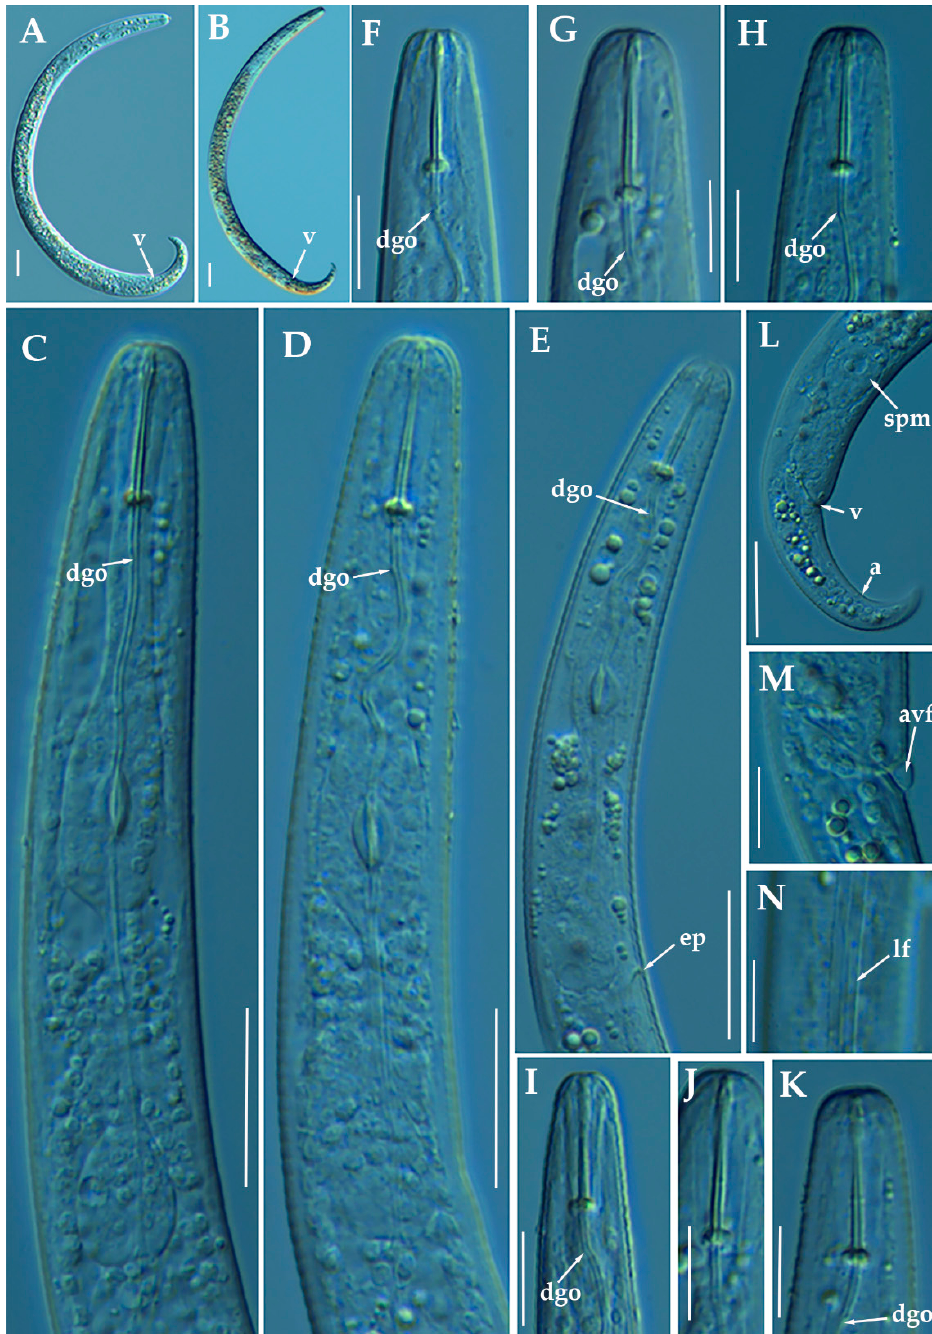
Figure 10. Light photomicrographs of female of Paratylenchus zurgenerus sp. nov. ( A , B ): Entire female with vulva arrowed; ( C – E ): Female pharyngeal region; ( F – K ): Female lip region; ( L ): Female posterior region showing empty spermatheca, vulva and anus (arrowed); ( M ): Detail of vulva showing advulval flap (arrowed); ( N ): Female mid-region with lateral field (arrowed). Scale bars ( A – E , L = 20 μ m; F – K , M , N = 10 μ m). (Abbreviations: a = anus; avf = advulval flap; dgo = pharyngeal dorsal gland orifice; ep = excretory pore; lf = lateral field; spm = spermatheca; V = vulva).